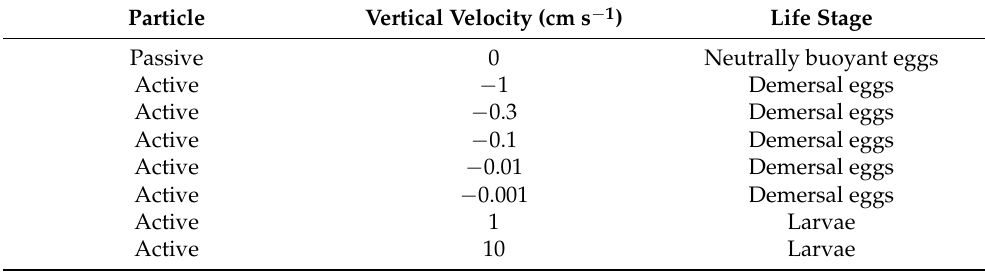
Table 1. Particle types, vertical velocity, and the life stage they represent. Negative values indicate downward